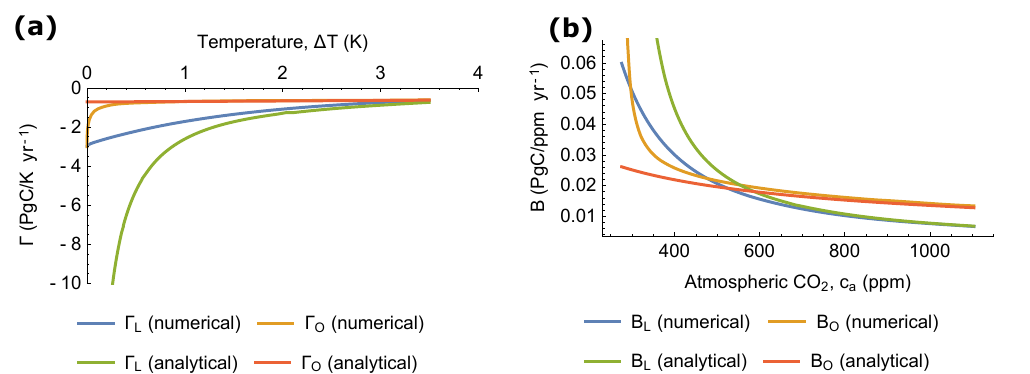
Figure A1. Direct feedback parameters, (a) climate–carbon feedbacks, and (b) concentration– carbon feedbacks.